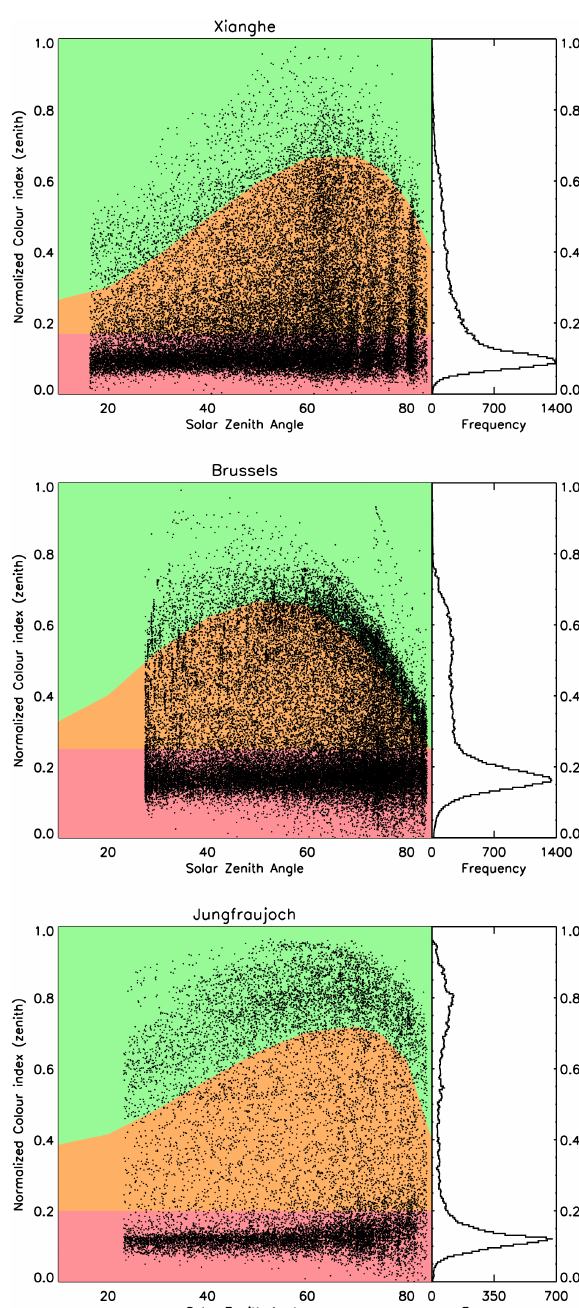
Figure 7. The normalized CI values (points) versus solar zenith an- gle. The green, orange and red regions correspond to the “good”, “mediocre” and “bad” regions as defined by the sky